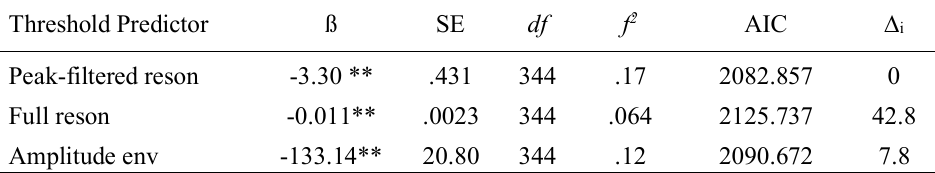
Table 1. Comparison of three alternative predictive models of perceptual threshold.